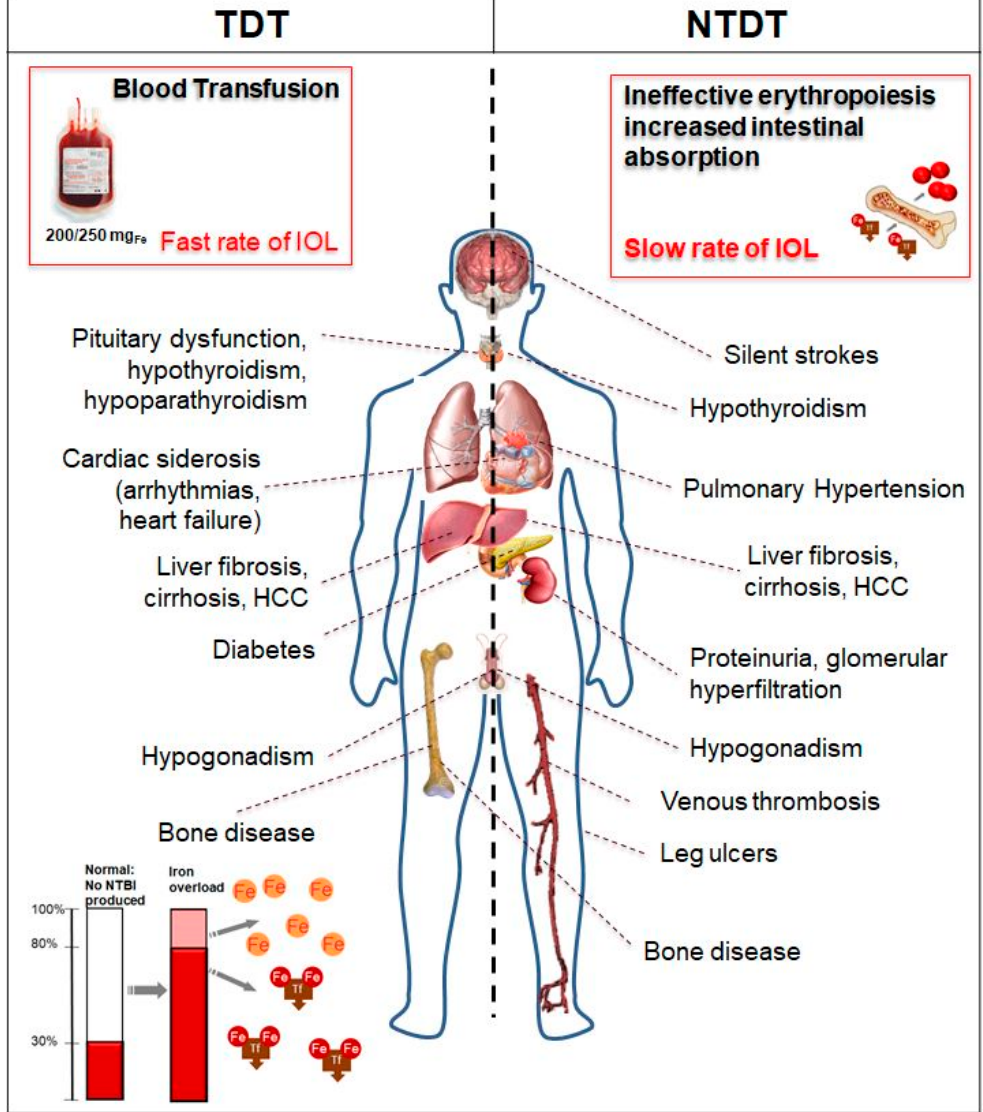
Figure 1. Target of iron overload (IOL) in transfusion-dependent thalassemia (TDT) and non-transfusion-dependent thalassemia (NTDT). HCC, hepatocellular carcinoma; NTBI, non-transferrin-bound iron; Fe, iron; Tf, transferrin.